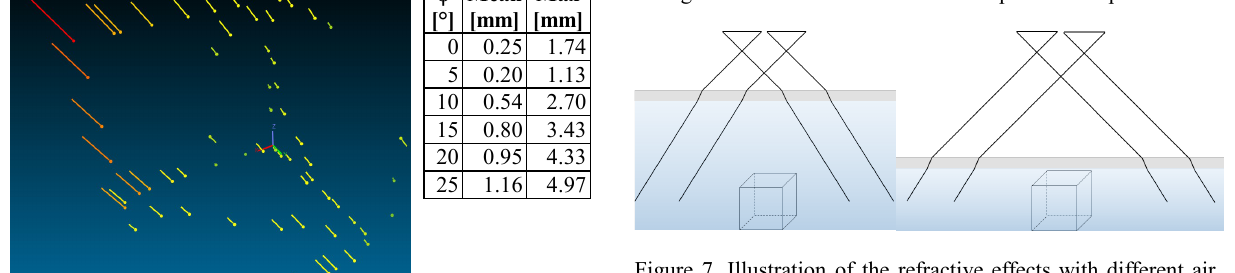
Figure 7. Illustration of the refractive effects with different air to water ratio.